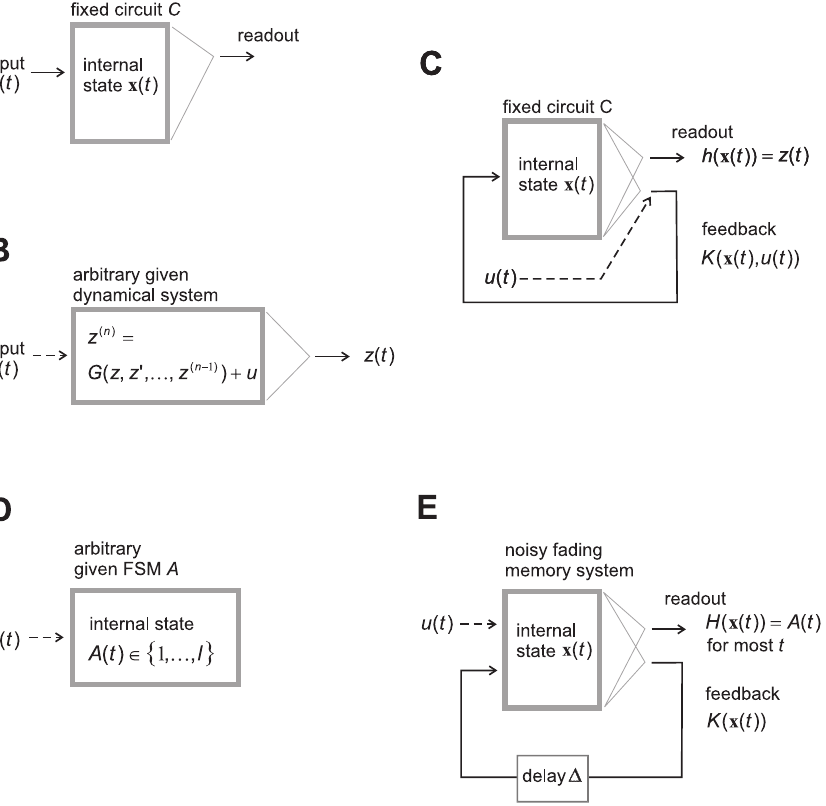
Figure 1. Computational Architectures Considered in Theorems 1 and 2 (A) A fixed circuit C whose dynamics is described by the system (Equation 3). (B) An arbitrary given n th order dynamical system (Equation 4) with external input u ( t ). (C) If the input v ( t ) to circuit C is replaced by a suitable feedback K ( x ( t ), u ( t )), then this fixed circuit C can simulate the dynamic response z ( t ) of the arbitrarily given system shown in B, for any input stream u ( t ). (D) Arbitrary given FSM A with l state. (E) A noisy fading-memory system with feedback can reliably reproduce the current state A ( t ) of the given FSM A, except for timepoints t shortly after A has switched its state.